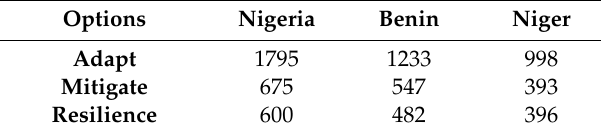
Table 11. Responses gathered across the three countries.